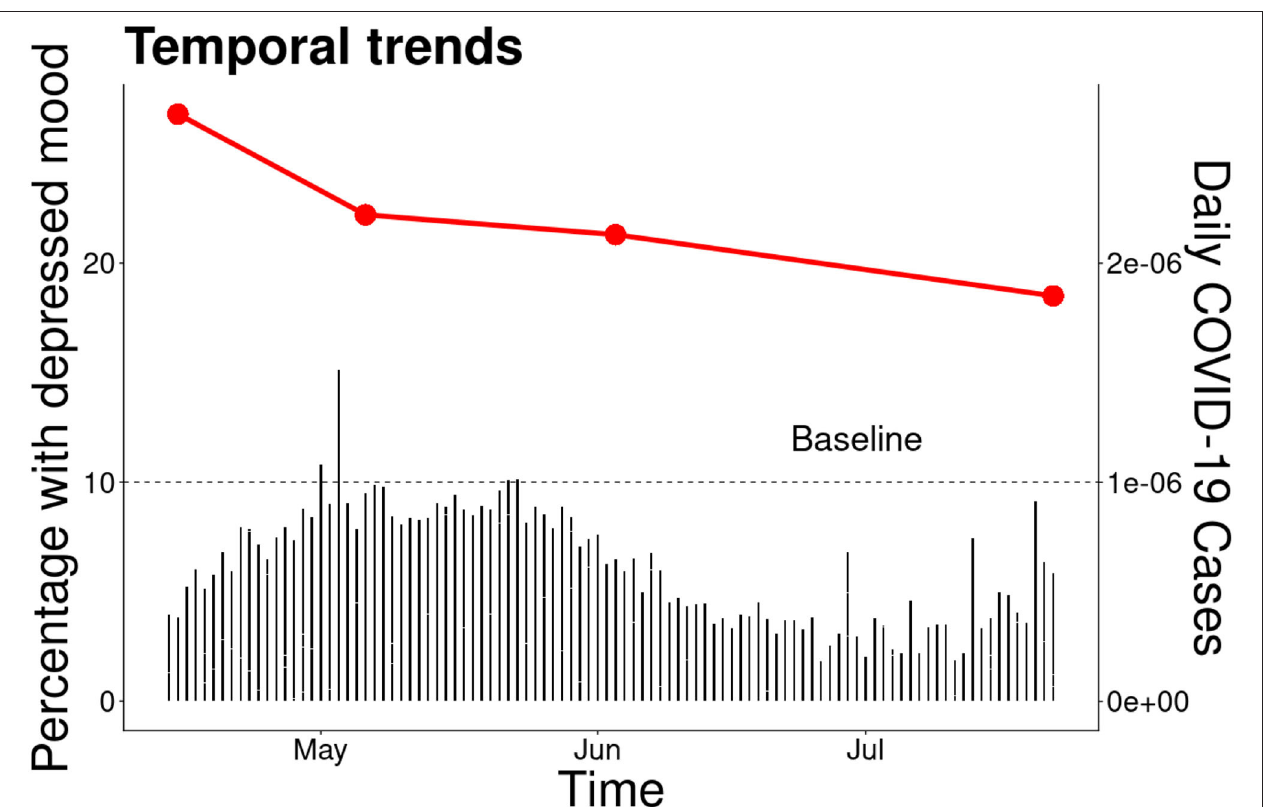
FIGURE 1 | Longitudinal trends in percentage of participants with 5 + score on the self-reported mood scale by study survey.